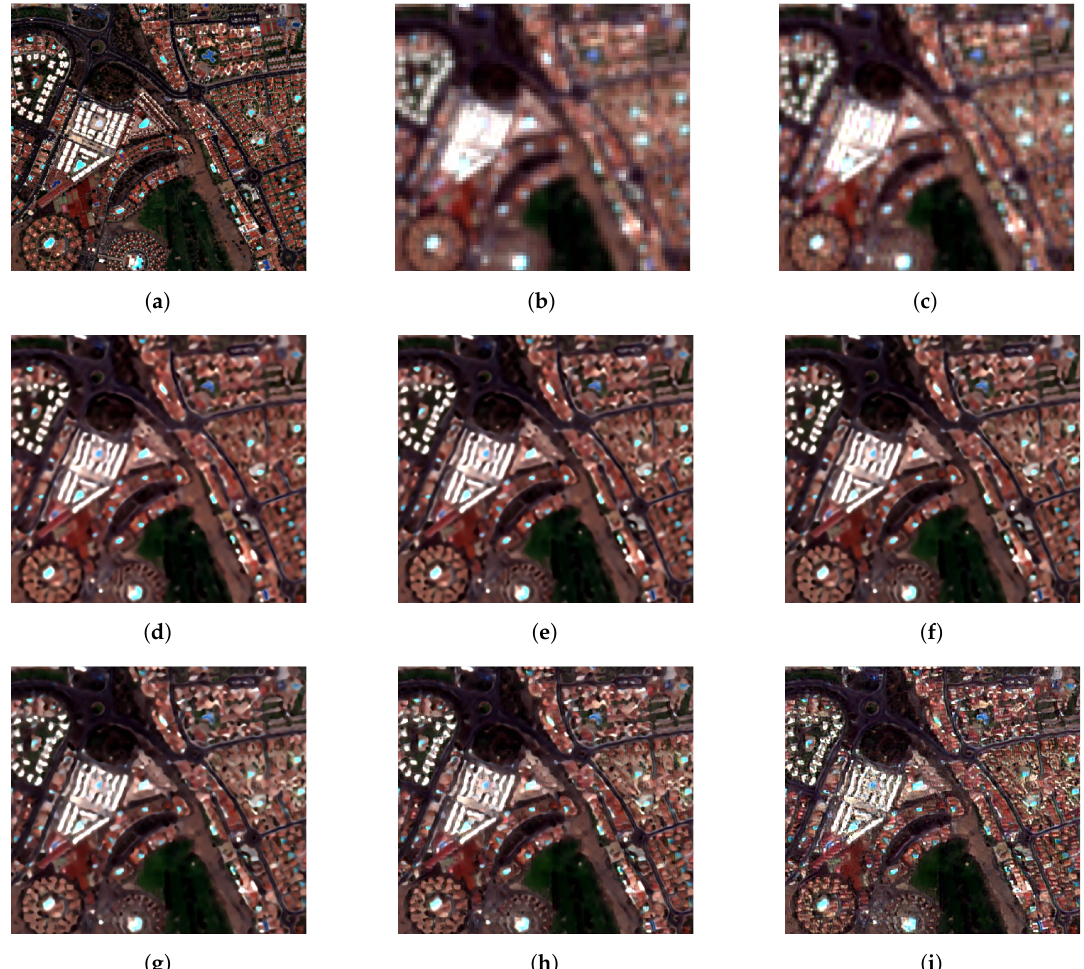
Figure 12. Results of a region of Maspalomas from the W-S Set2. ( a ) HR, ( b ) LR with NN interpolation, ( c ) LR with bicubic interpolation, ( d ) SR with α = 0, ( e ) SR with α = 0.1, ( f ) SR with α = 0.2, ( g ) SR with α = 0.5, ( h ) SR with α = 0.7, ( i ) SR with α = 1. Image size: 378 × 256 pixels. Table 5. Quality metrics results on the W-S Set2 for nearest neighbor (LR_nn) and bicubic (LR_cub) interpolation and our method SR_ α for different values of α